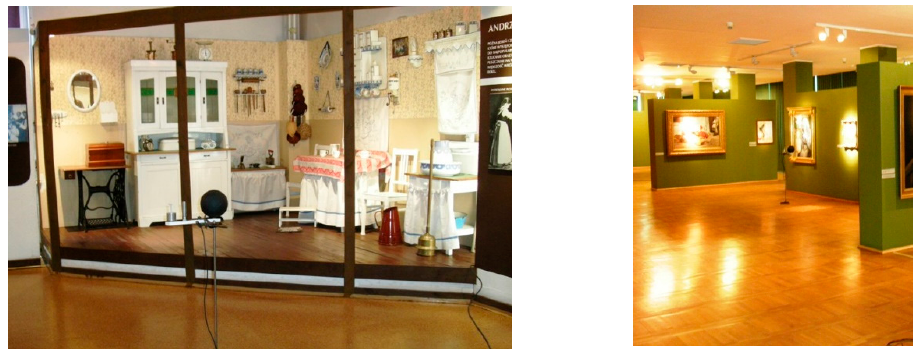
Figure 2. Examples of museum exhibits in the ethnography hall (left) and the Gallery of Painting (right).